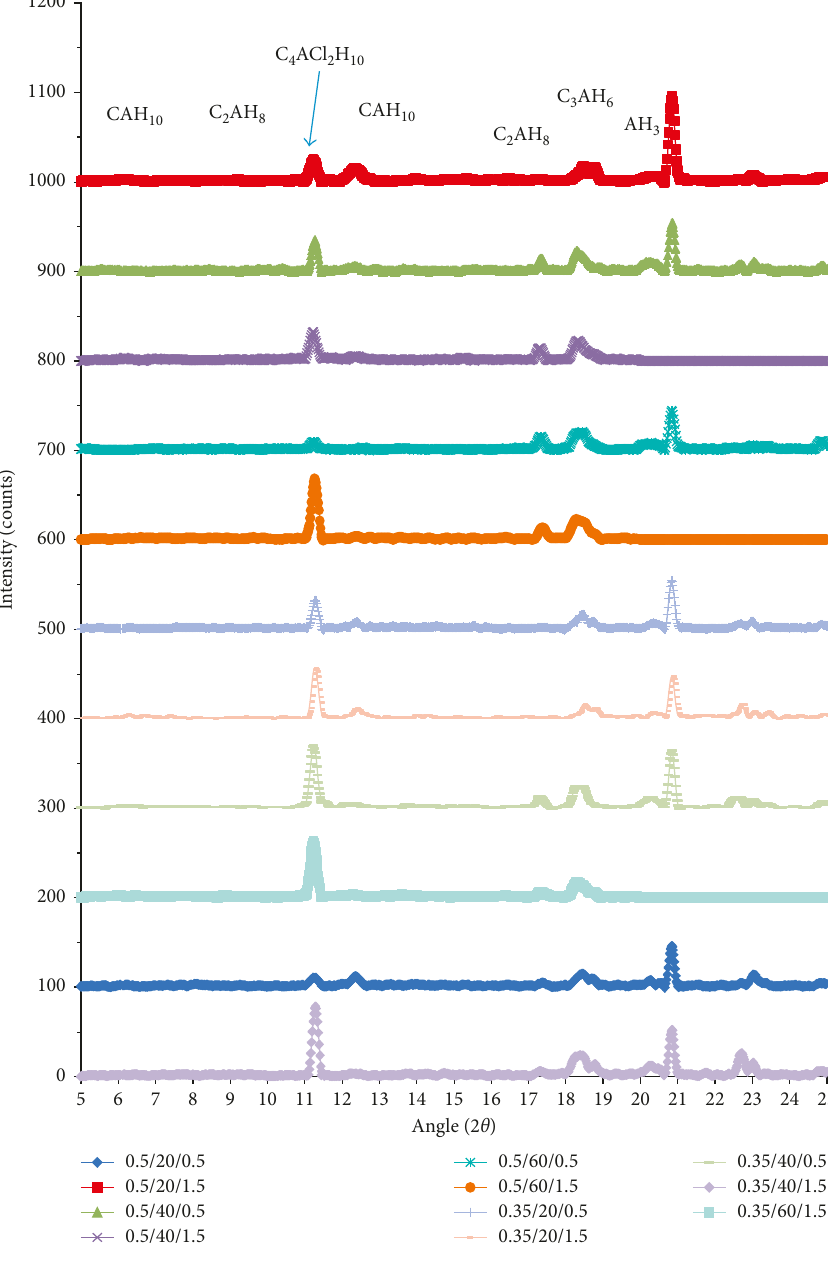
Figure 2: XRD diffractograms after five years of